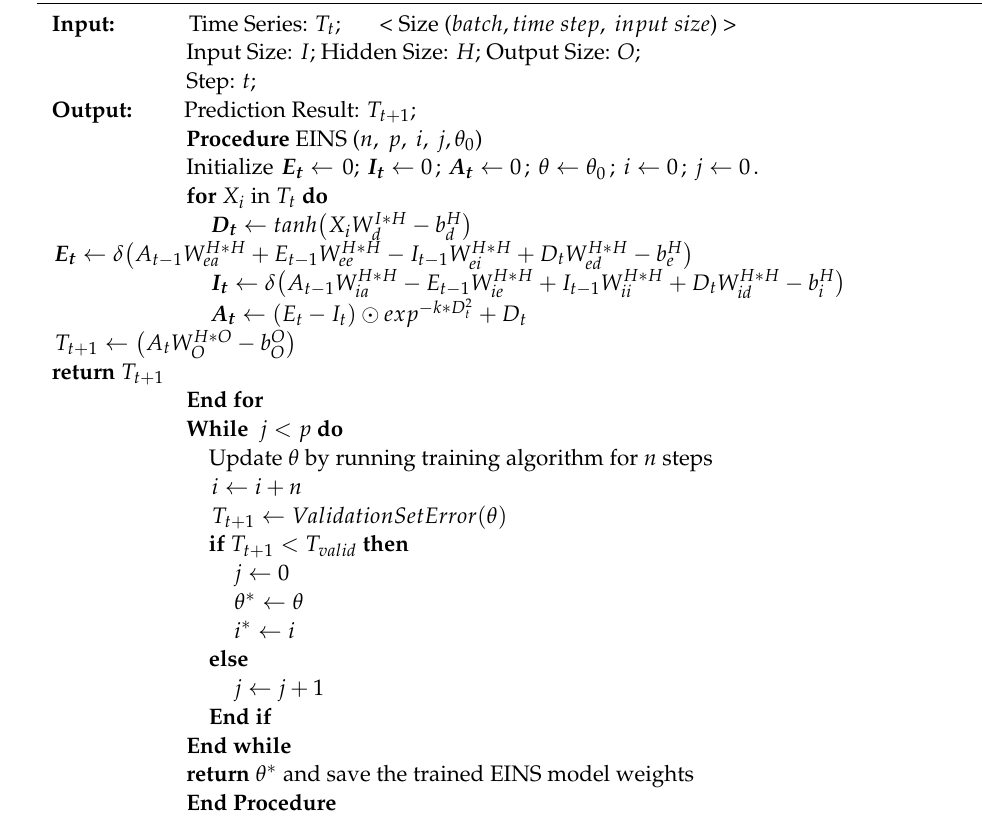
Algorithm 2. Algorithm to Excitatory and Inhibitory Neural Synapse